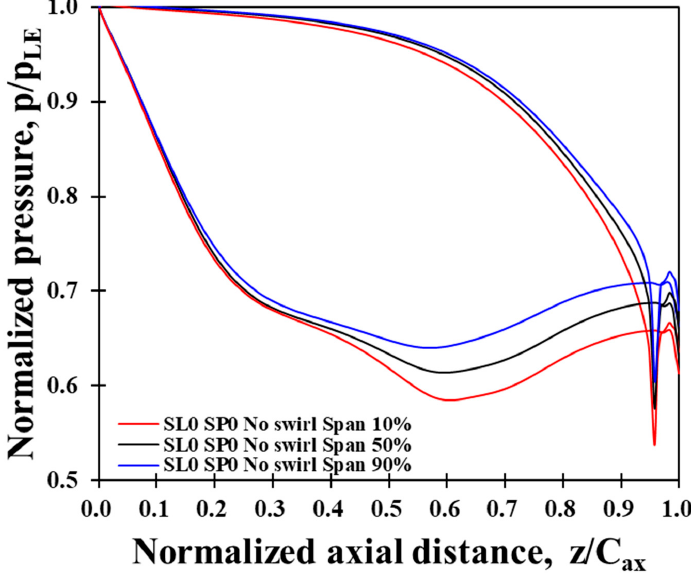
Figure 12. Loading distribution of NGV loading at 10, 50 and 90% span heights.